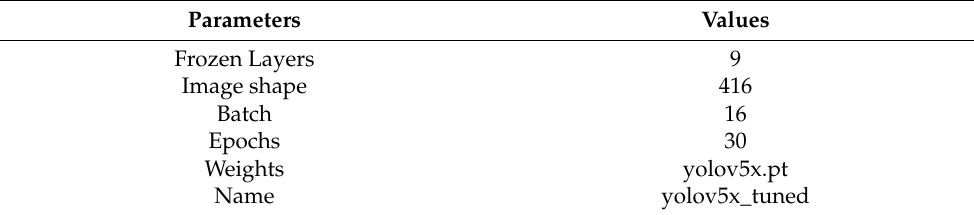
Table 4. Transfer learning parameters used for training the YOLOv5